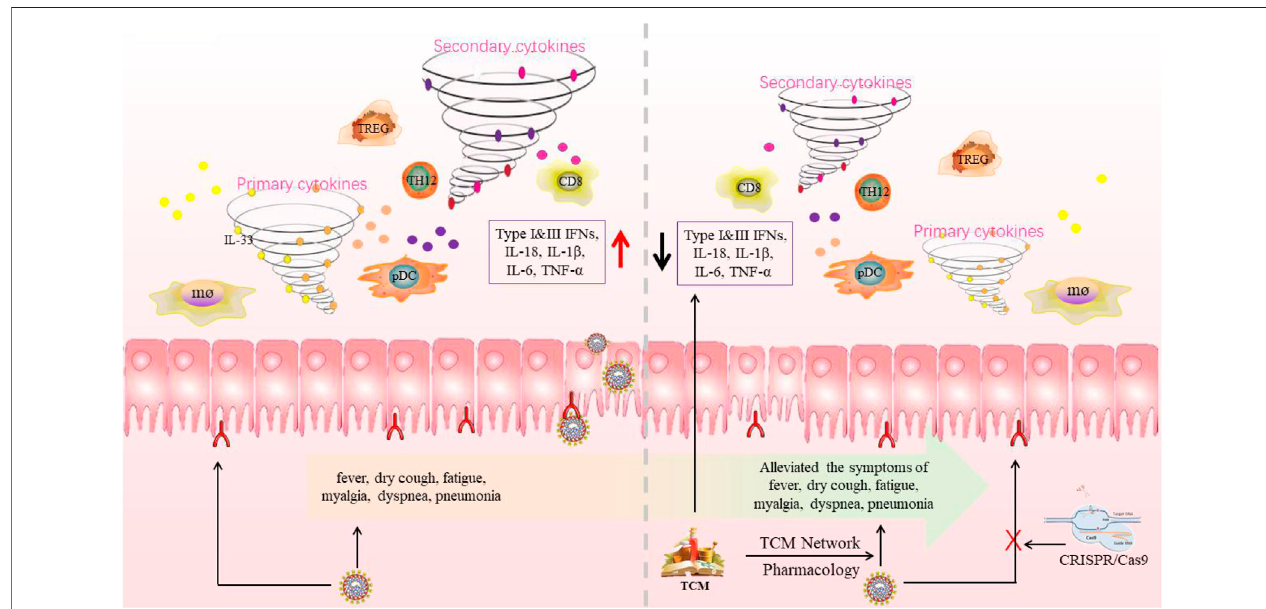
FIGURE 4 | The future expectation of therapeutic methods in the treatment of COVID-19 patients. The researchers will specially use the gRNAs targeting both ORF1ab and S genes of SARS-CoV-2 in order to destroy the function of the virus and the toxicity of natural products by subtracting toxic genes through gene editing. Meanwhile, we can use the TCMSP database to predict and screen the effective active ingredients of related TCM and sort out the ingredients of each prescription respectively by using the network pharmacology method to treat COVID-19.